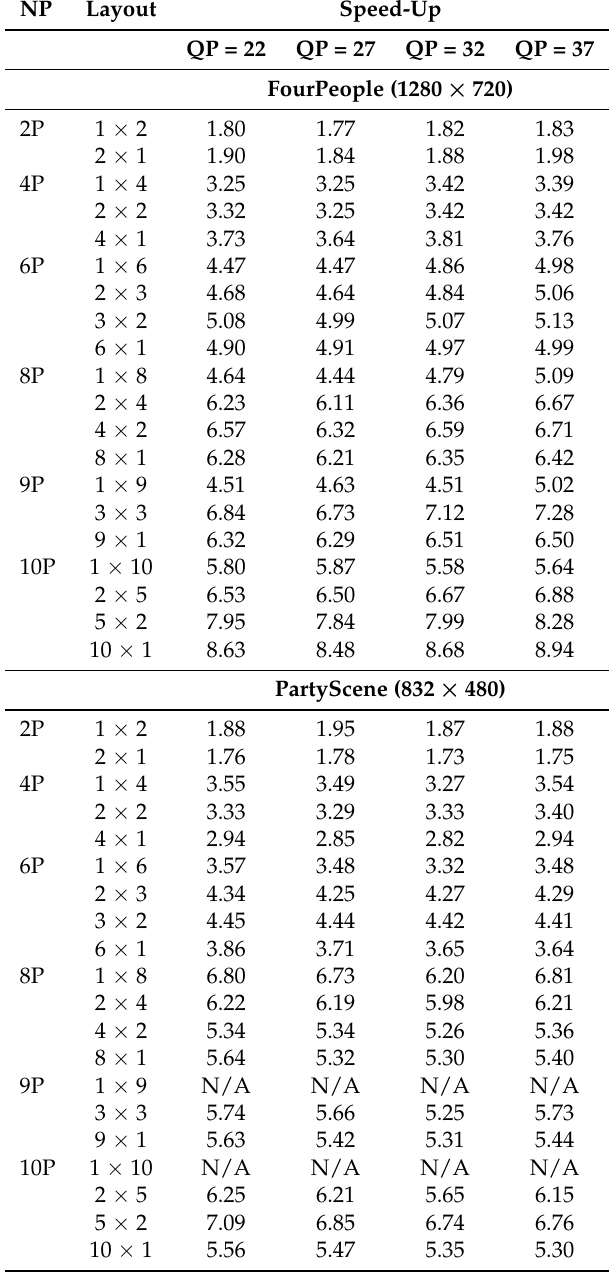
Table 6. Speed-up evolution for low resolution video sequences for the tile-based parallel